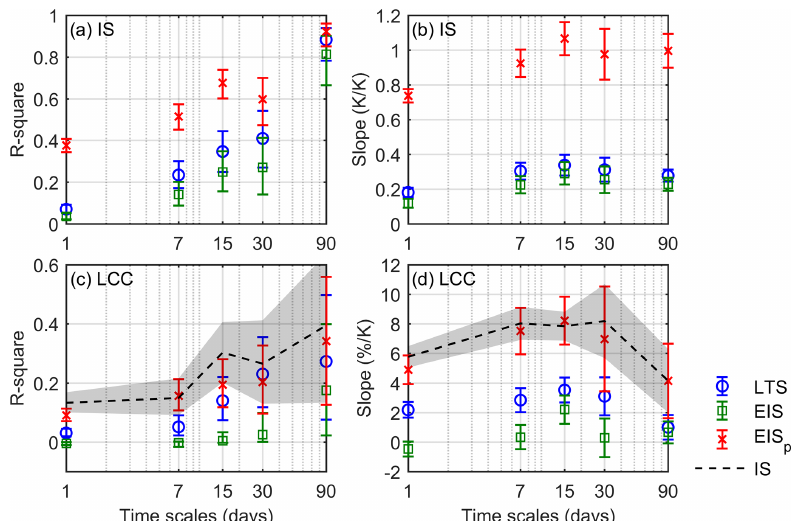
Figure 6. R square (a) and slope of the least-squares fit (b) of the SGP radiosonde-derived IS to the ERA5 reanalysis-based LTS (blue cycle), EIS (green square) and EIS p (red cross) on daily, 7, 15, 30 and 90d timescales, respectively. R square (c) and slope (d) of LCC to the LTS, EIS, EIS p and IS (dashed black line) on daily to seasonal timescales, respectively. Error bars and shadows show the 95% confidence interval of the mean based on the t